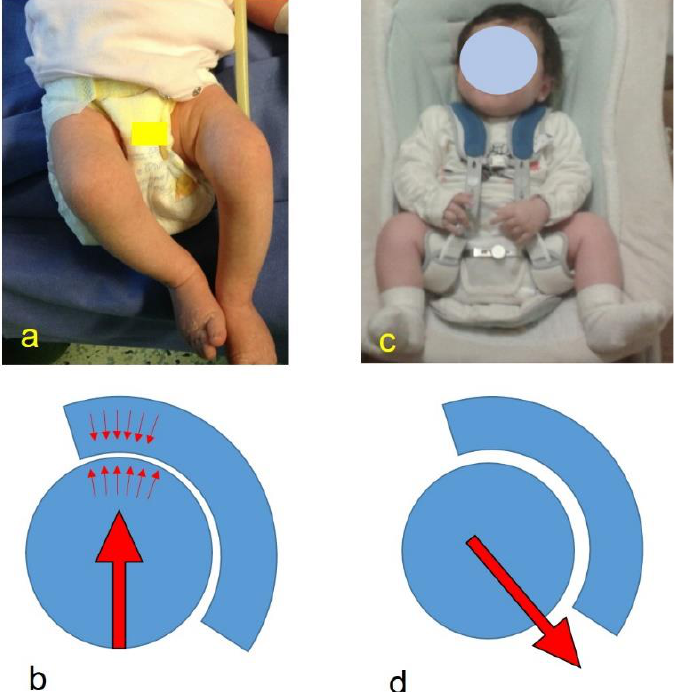
Figure 4. ( a ) Spontaneous hip position with extended and adducted hips; ( b ) diagram to note the force vector’s direction (arrow) and the head’s pressure on the acetabulum (small arrows); ( c ) 2- month-old infant treated with harness for developmental dysplasia of the hip (DDH), with hip flexed and abducted; ( d ) diagram to note the modified direction of the force vector.